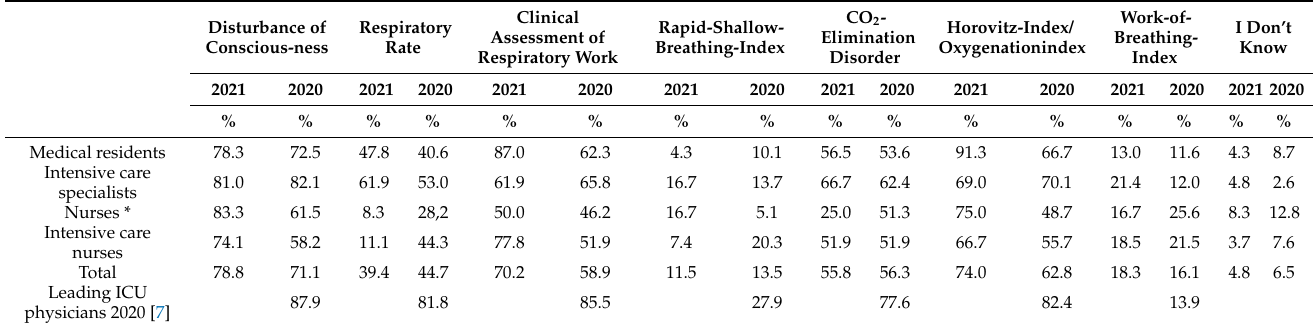
Table 4. Percentage of use of different discontinuation criteria for NIV for different occupational